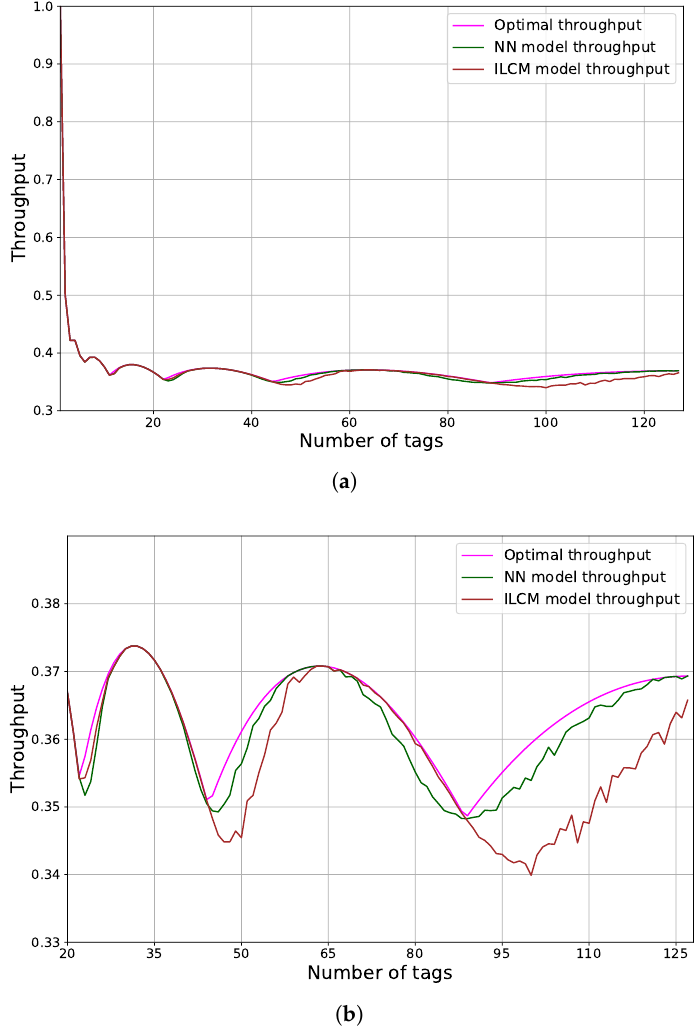
Figure 5. Comparison of throughput for the NN model, ILCM and Optimal model for the scenario of frame size L = 32 realizations. ( a ) Throughput for the NN model, ILCM and Optimal model; ( b ) Throughput for the NN model, ILCM and Optimal model for a larger number of tags. Based on the result of this examination of the performance of classifiers and compar- ison to the ILCM model, architectures of the Neural Network models were selected for further